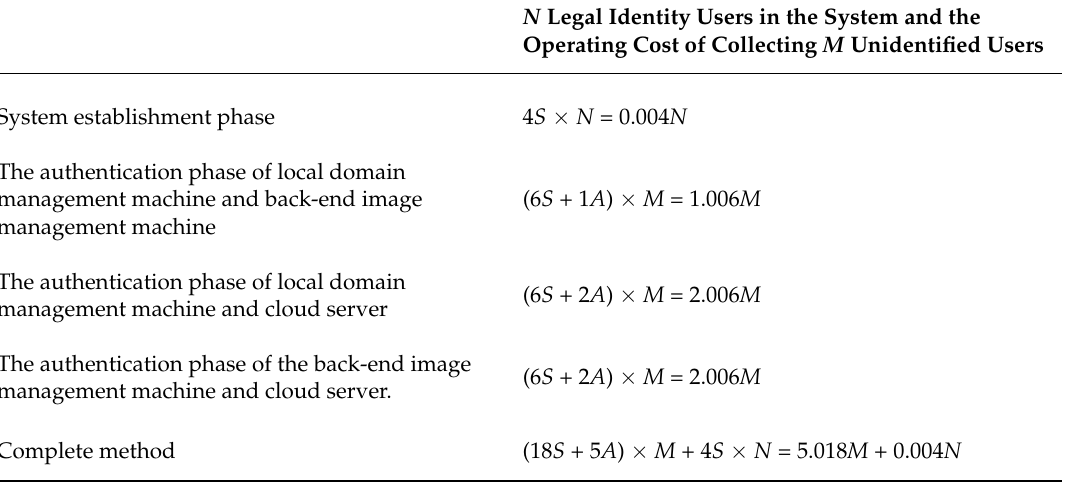
Table 3. Method costs. S , symmetric; A ,